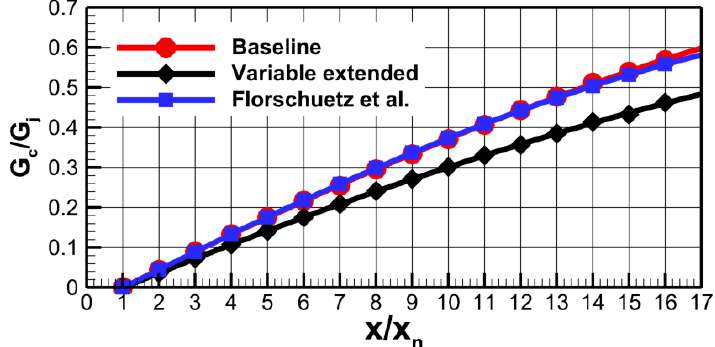
Figure 11. Streamwise distributions of crossflow-to-jet mass flow flux ratios: comparisons between the baseline, variable extended, and correlation of Florschuetz et al. [35].